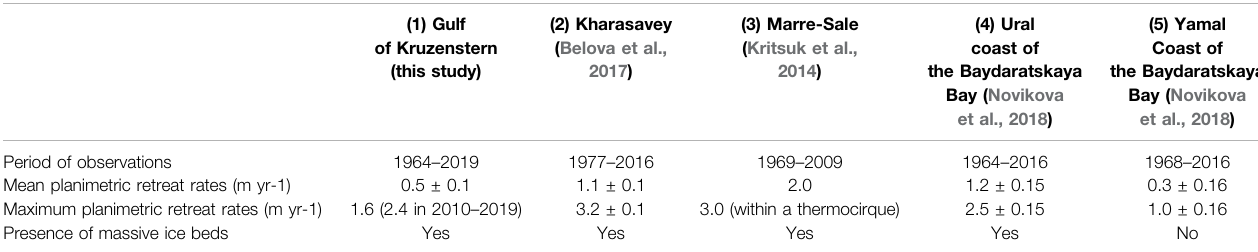
TABLE 2 | Comparison of shoreline retreat at key sites of monitoring in the southwestern Kara Sea.